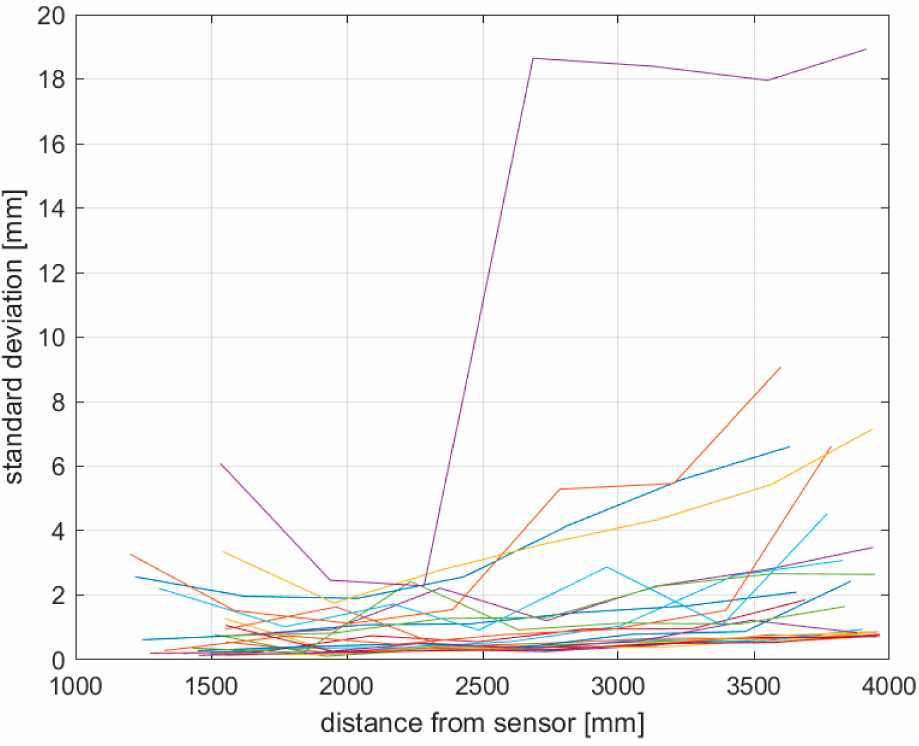
Figure 10. Body joint precision measurements of Kinect v2.